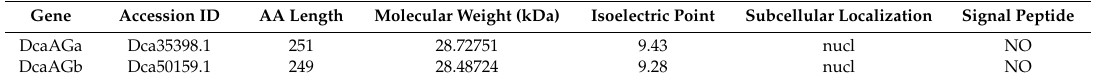
Table 2. Protein properties of DcaAGa and